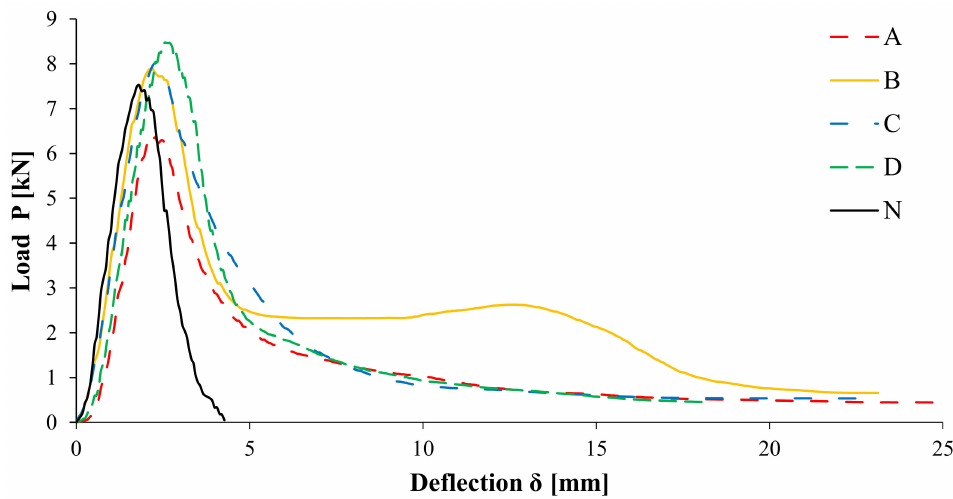
Figure 7. Average load-deflection curves from three-point bending